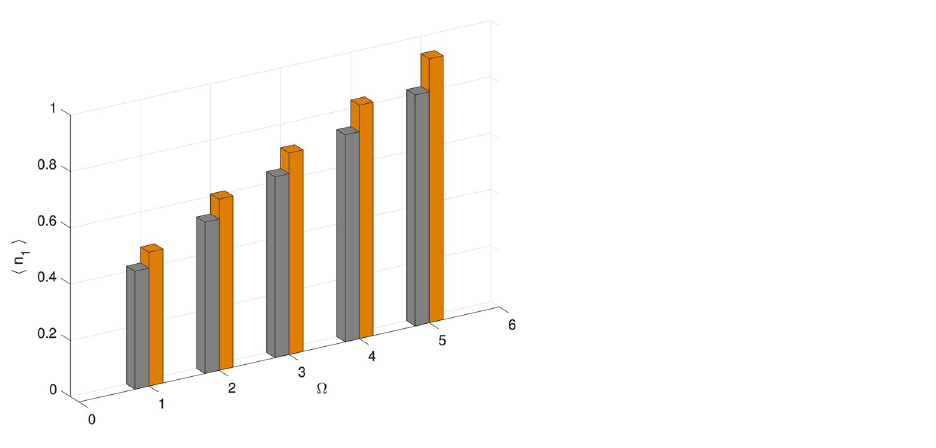
Figure 4. Boson number expectation value on site 1 as function of varying drive strength (Ω) for a disordered trimer. Gray bars correspond to the lower sign choice in the parameters listed in Table 1(b), Case 2; and orange bars correspond to the upper sign choice. The transformation from the lower sign choice to the upper sign choice is not number-conserving and the boson number expectation value is not